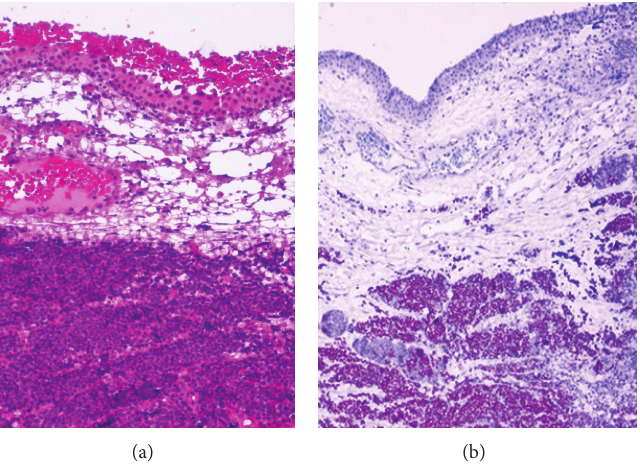
Figure 2: (a) Photomicrograph showing cellular neoplasm with darkly staining nuclei and scanty cytoplasm in the subepithelial stroma of the conjunctiva (stain, hematoxylin-eosin; original magnification, × 200). (b) Photomicrograph showing intense immunoreactivity to thyroid transcription factor- (TTF-) 1, consistent with small cell lung cancer (stain, TTF-1; original magnification, ×